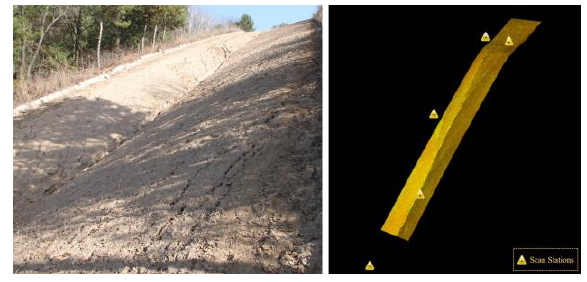
Figure 3 Five monitoring